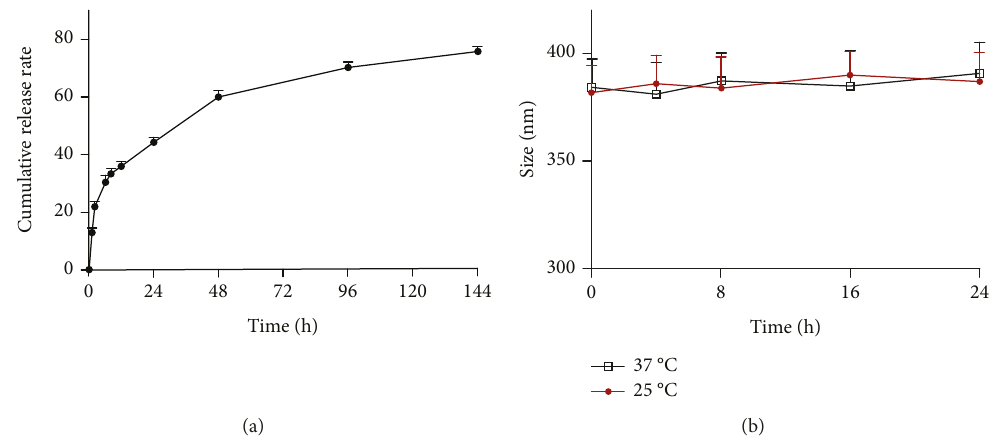
Figure 3: In vitro drug release characteristics of AsCs NPs. (a) Cumulative release of AsCs NPs in PBS ( pH = 7 4 ). (b) 24-hour stability study of AsCs NPs in 10% FBS.